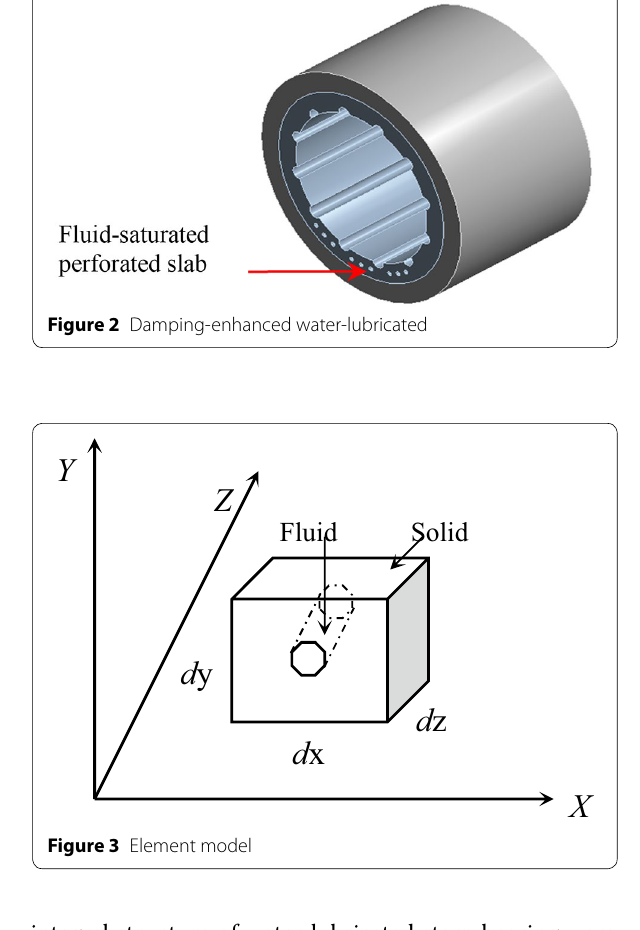
boundary of the solid-fluid phase remains continuous without mass exchange, and the kinetic energy of the unit body is expressed as: